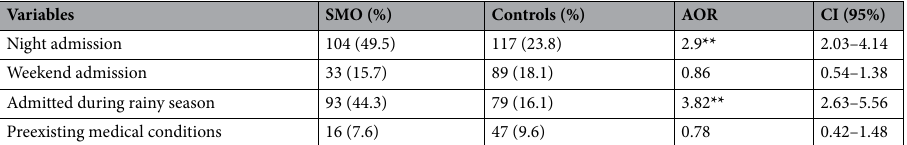
Table 6. Miscellaneous variables related to quality of obstetric care as determinants of maternal outcome among women admitted to Keren Hospital. **Significant at 0.01.